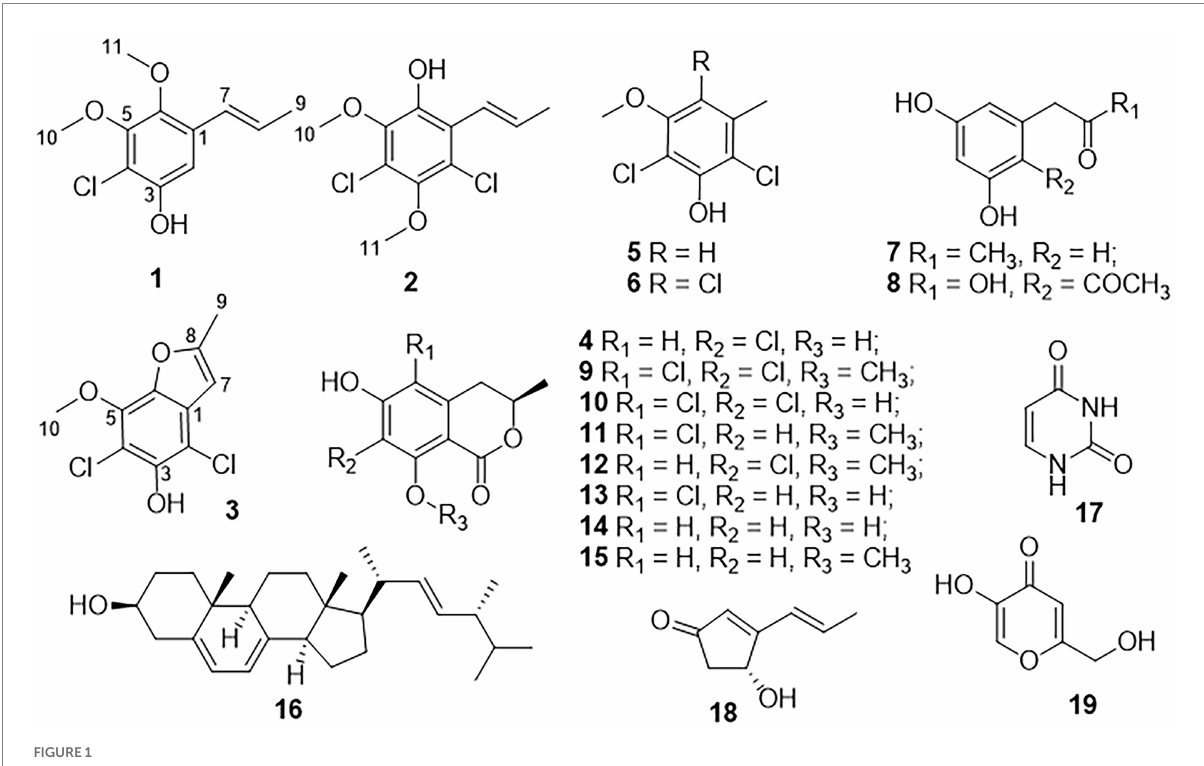
FIGURE 1 Structures of compounds 1 – 19